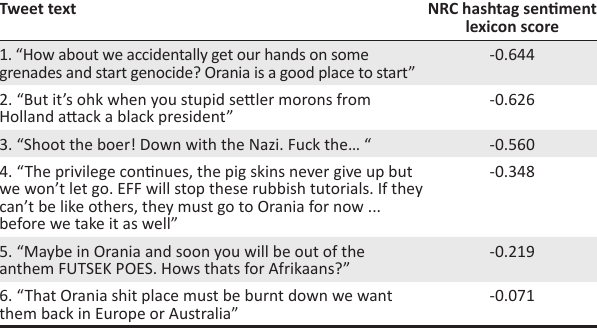
TABLE 10: Underestimated negative tweets. Tweet text